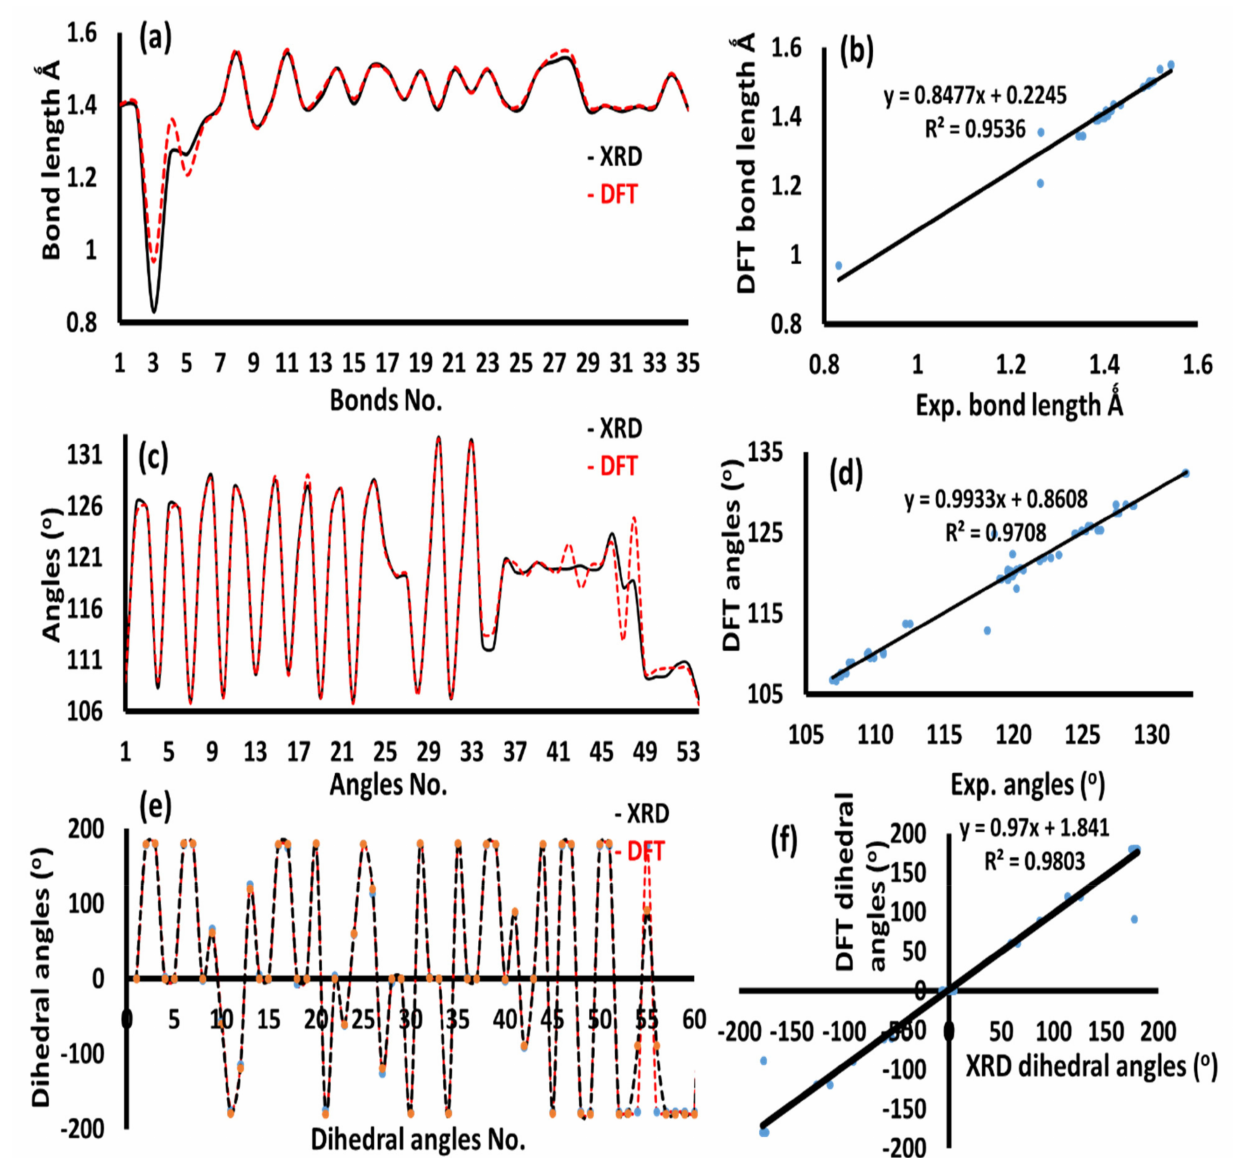
Figure 3. ( a ) Histogram of XRD/DFT bond lengths and its ( b ) correlation coefficient, ( c ) Histogram of XRD/DFT angles and its ( d ) correlation coefficient, ( e ) Histogram of XRD/DFT dihedral angles and its ( f ) correlation